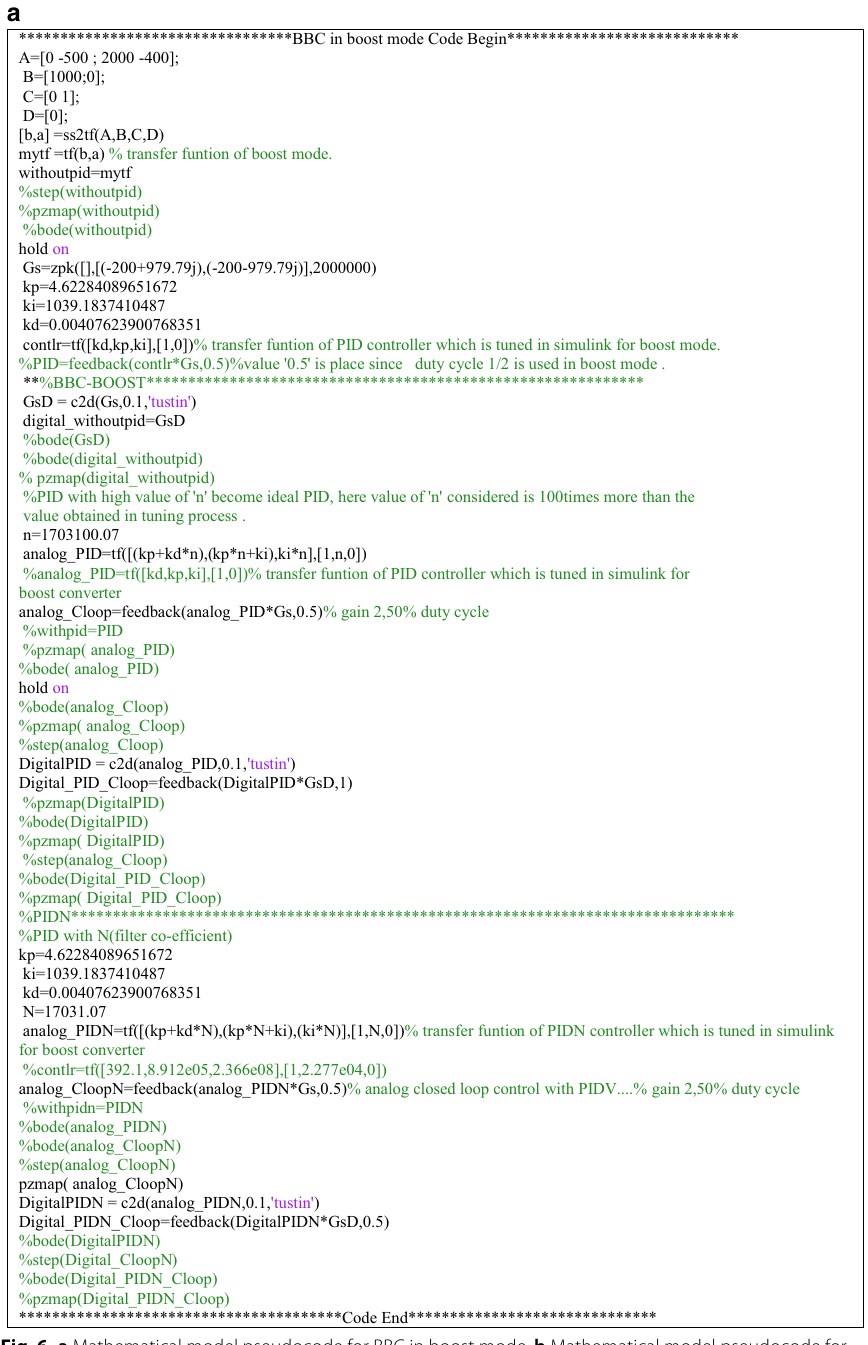
Fig. 6 a Mathematical model pseudocode for BBC in boost mode. b Mathematical model pseudocode for BBC in buck